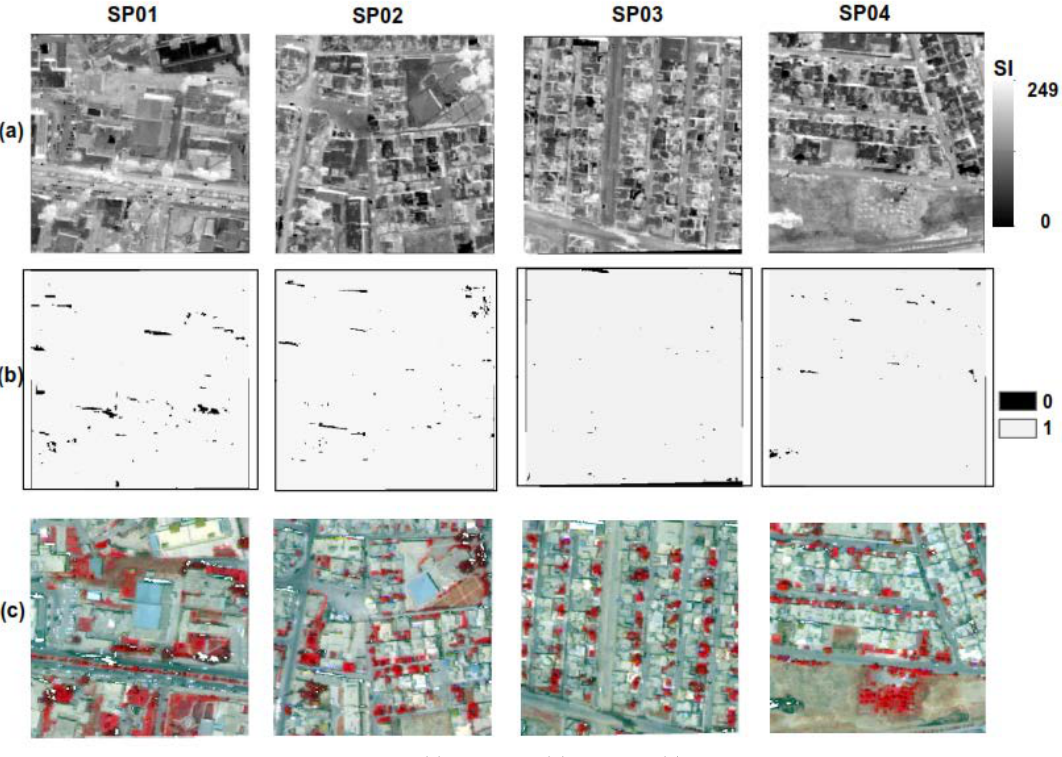
Figure 4: SI process of four VHR samples. (a) SI image, (b) SI mask, (c) Final output: image without shadow.